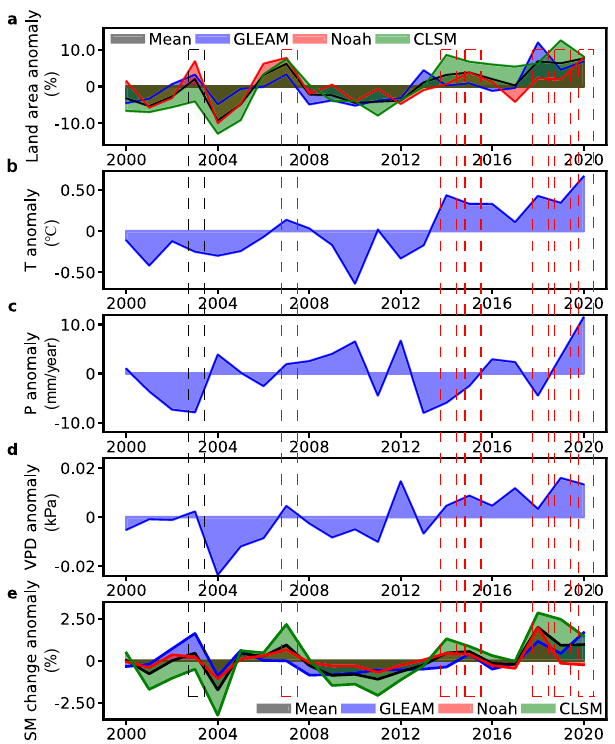
Fig. 3 Interannual variations of fl ash drought-affected land area and its related variables over the NEU-MEU from 2000 to 2020. a , e Anomalies of fl ash drought-affected land area and relative SM change over the NEU- MEU from three different datasets. The relative SM change is de fi ned as the change of SM percentiles between adjacent pentads (current and next- pentad SM percentiles), where positive values represent a decline in SM at the current pentad. b – d Anomalies of annual mean T, annual total P, and annual mean VPD over the